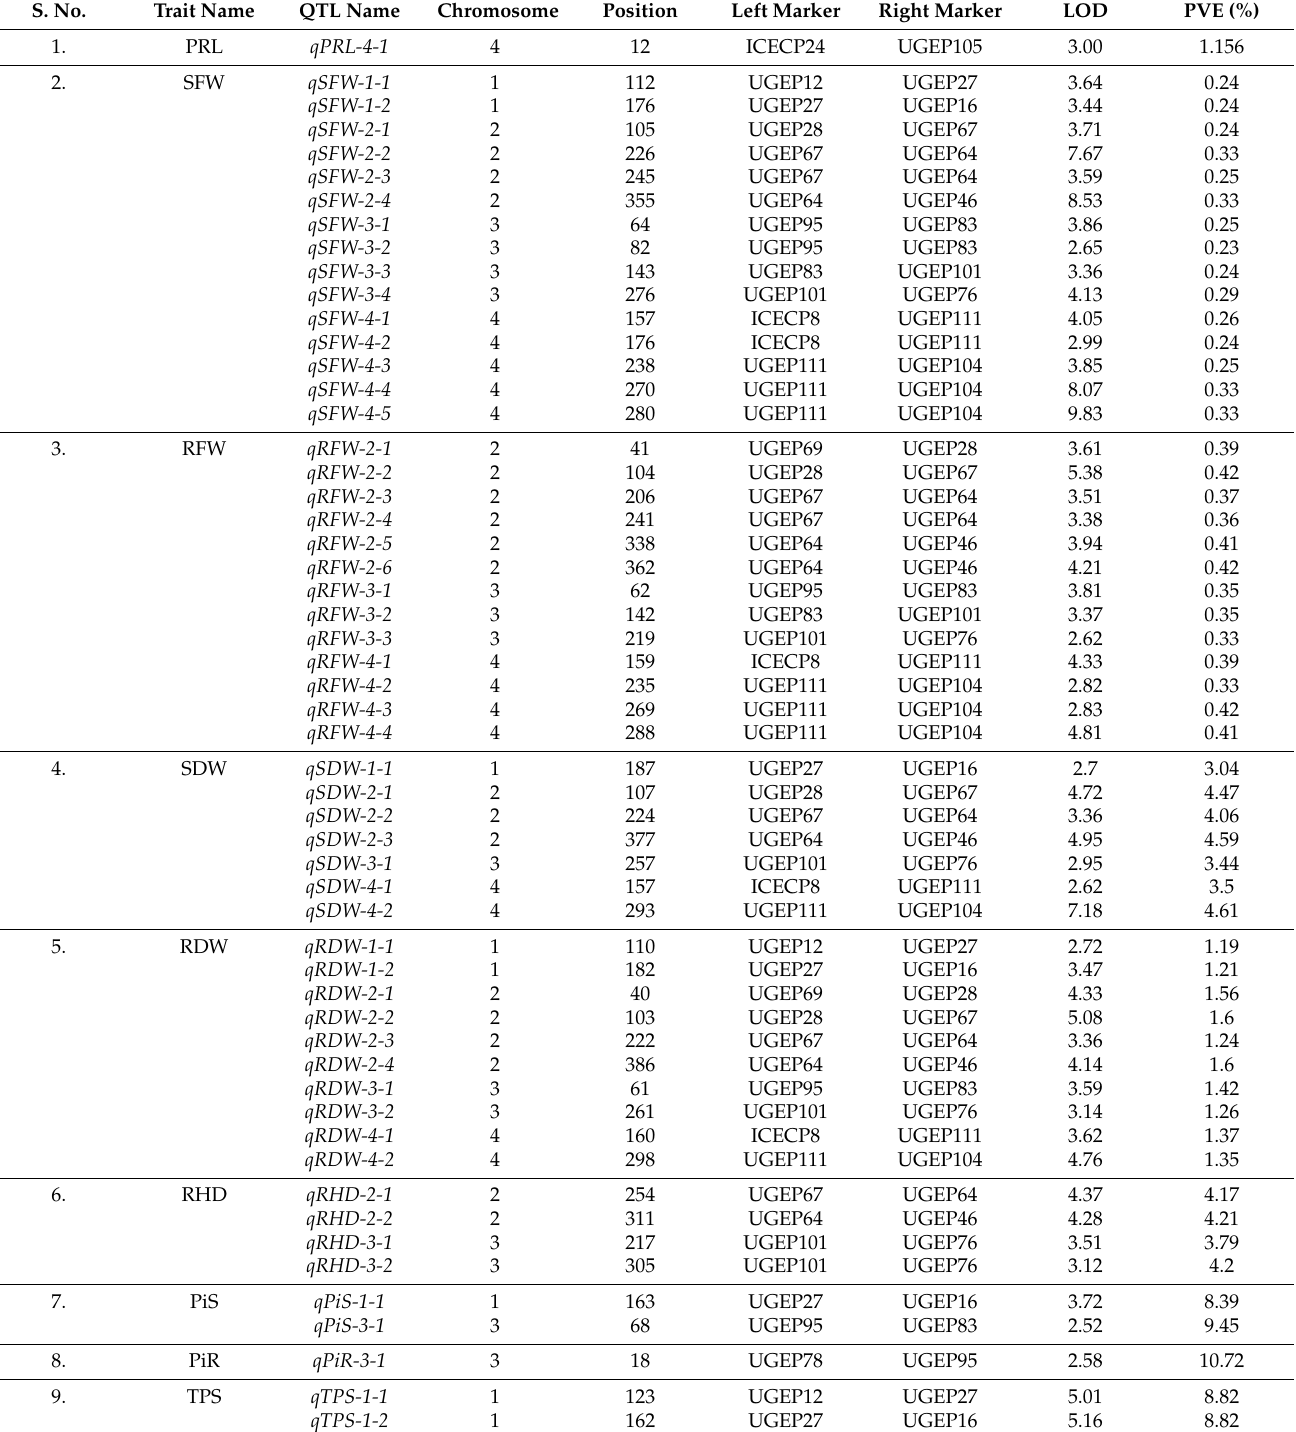
Table 4. Putative QTL identified for various agro-morphological and P-content traits via linkage mapping, using 100 RILs derived from IE-2606 and PR-202